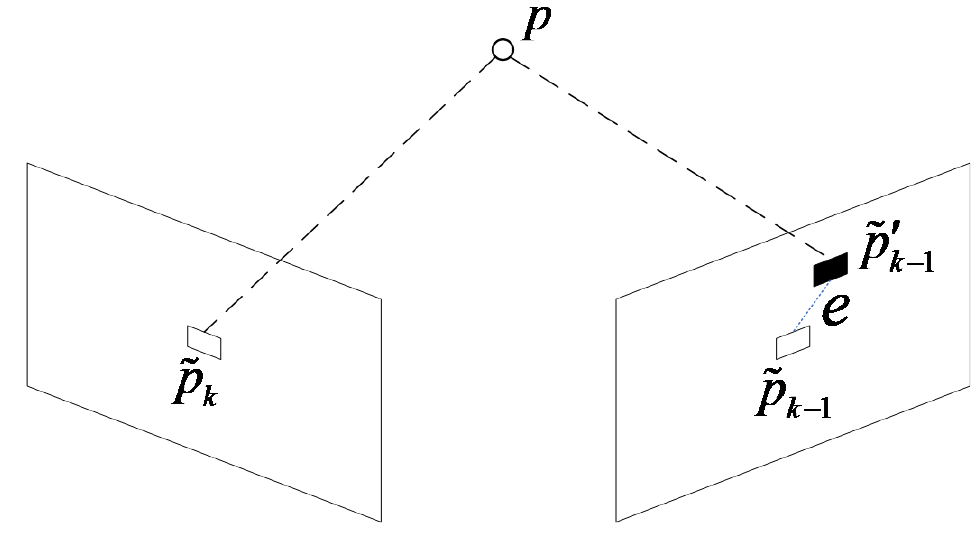
Figure 3. Schematic diagram of reprojection error.